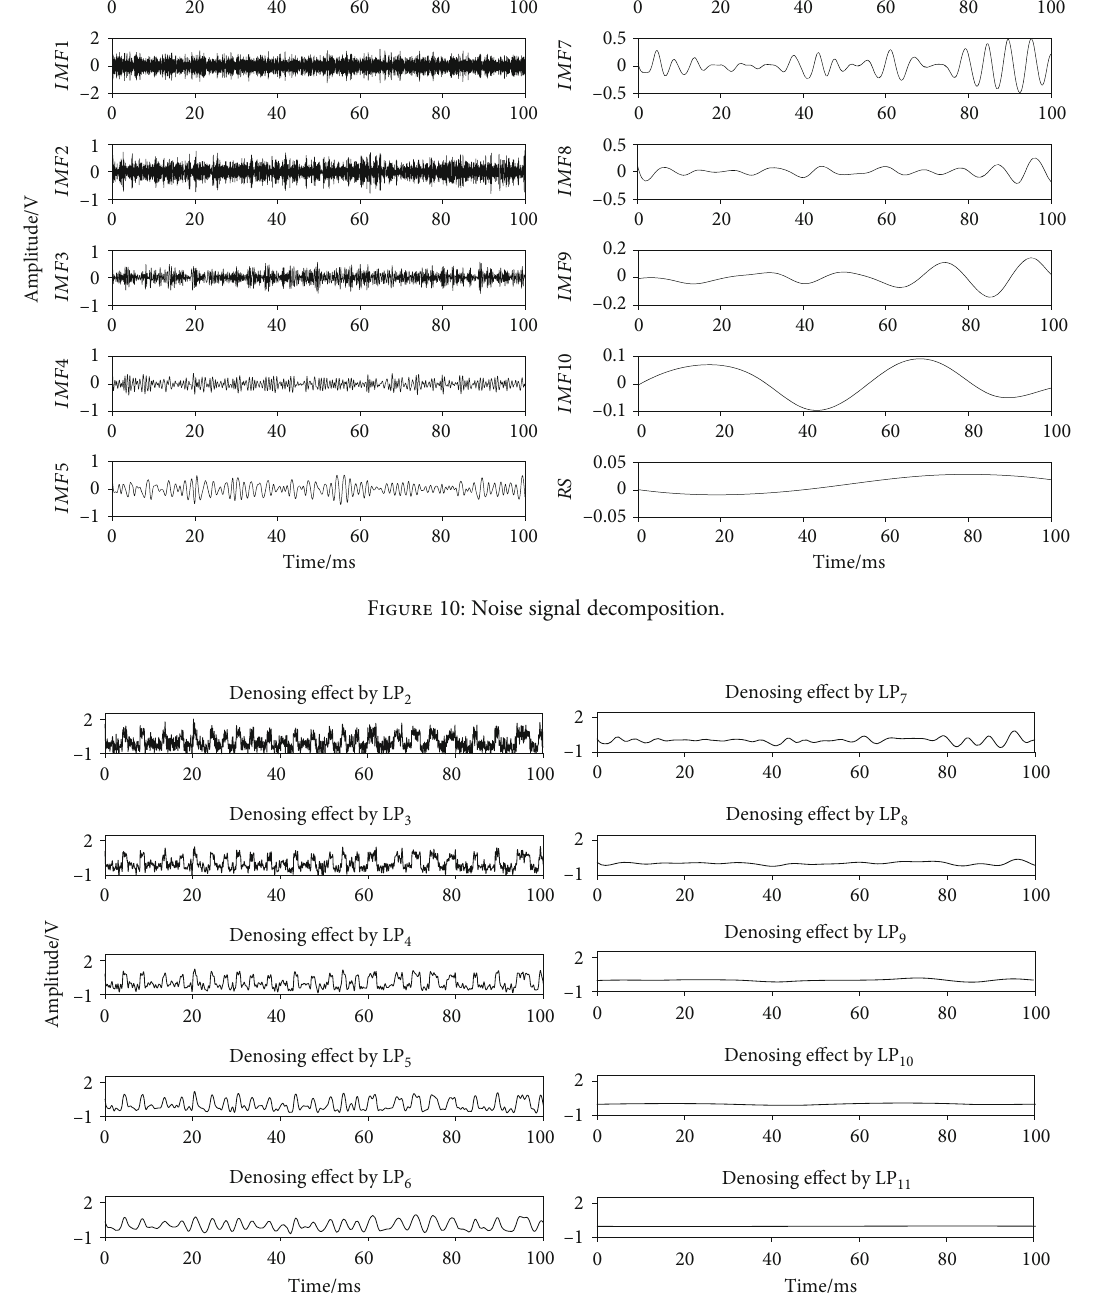
Figure 11: Noise reduction e ff ect of di ff erent scale fi